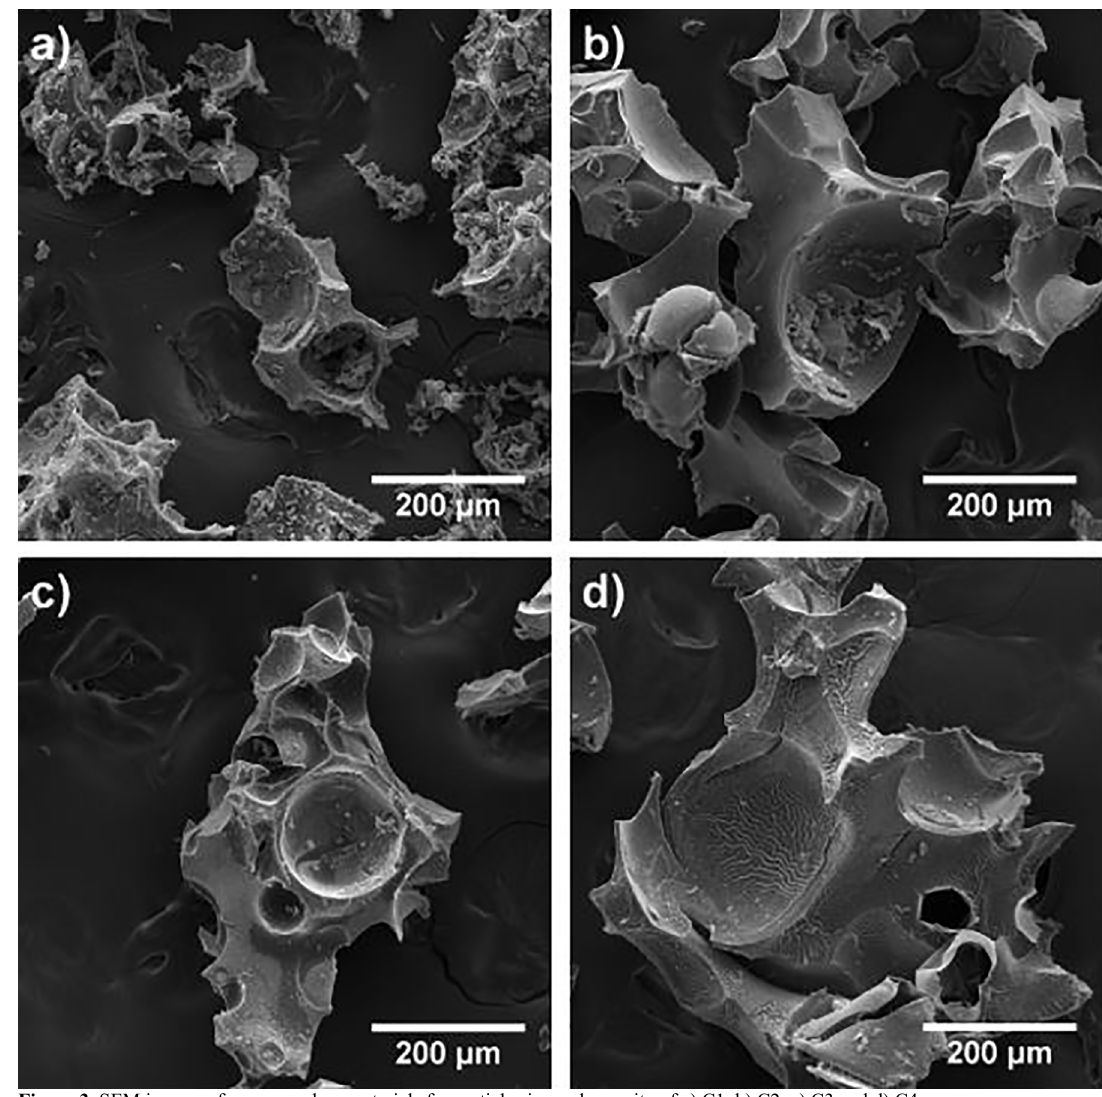
Figure 3. SEM images of porous carbon materials for particle size and porosity of a) C1, b) C2, c) C3 and d) C4. Table 3. Porosity data from mercury porosimetry